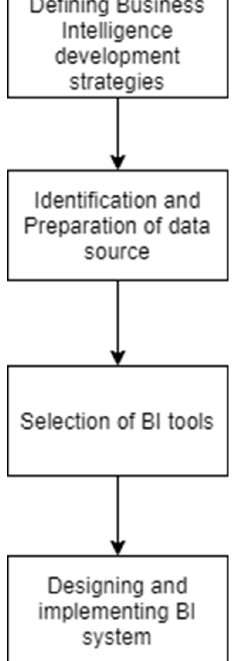
Fig. 1. Business Intelligence Development